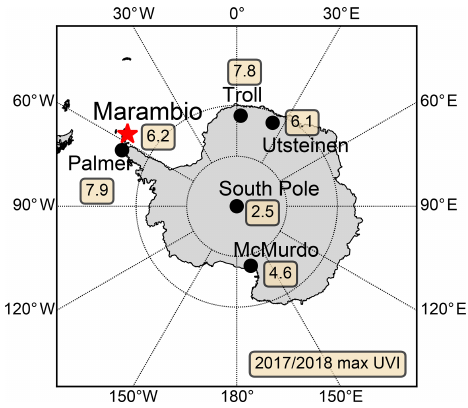
Figure 1. Locations of the stations included in the analysis. The numbers next to the sites show the corresponding maximum UVI measured during the season